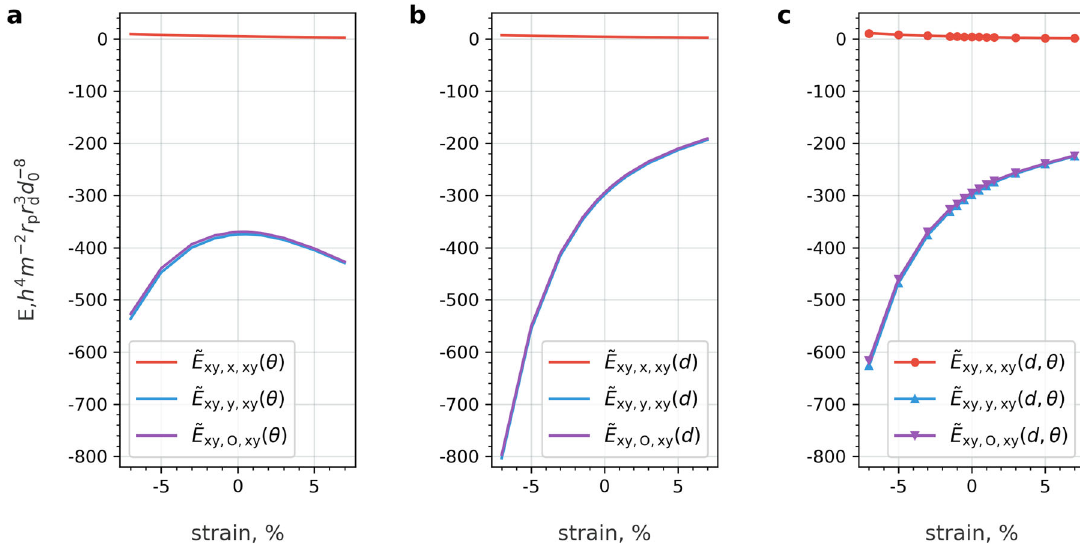
Fig. 4 Dependency of Slater-Koster Ir-O-Ir integrals on the strain. Slater-Koster integrals for indirect hopping between rotated Ir NN orbitals ~ E via oxygen p orbitals as a function of a Octahedra in-plane rotation angle θ , b Ir-Ir distance d , c both θ and d (calculated using values of θ and d extracted from DFT shown in Fig.